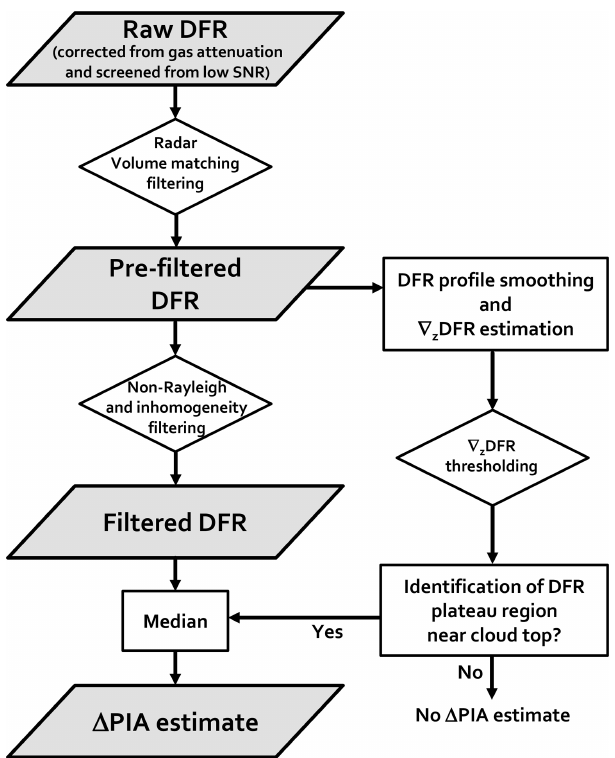
Figure 2. Flow chart of the DFR Rayleigh plateau method for es- timating the (cid:49) PIA from DFR profiles (see detailed explanations in the text). Parallelograms, diamonds, and rectangles represent input and output, task, and decision,